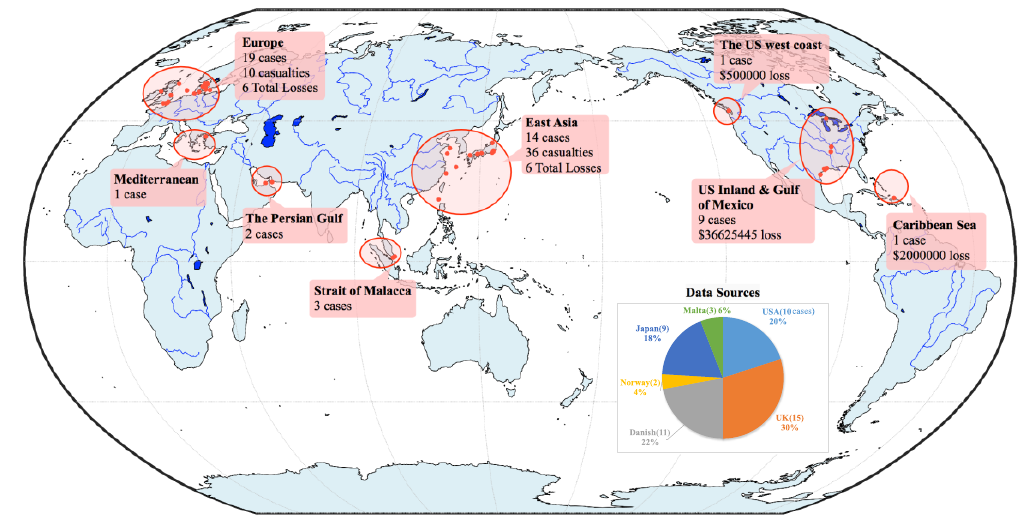
Figure 2. Regions of accidents considered in analysis.